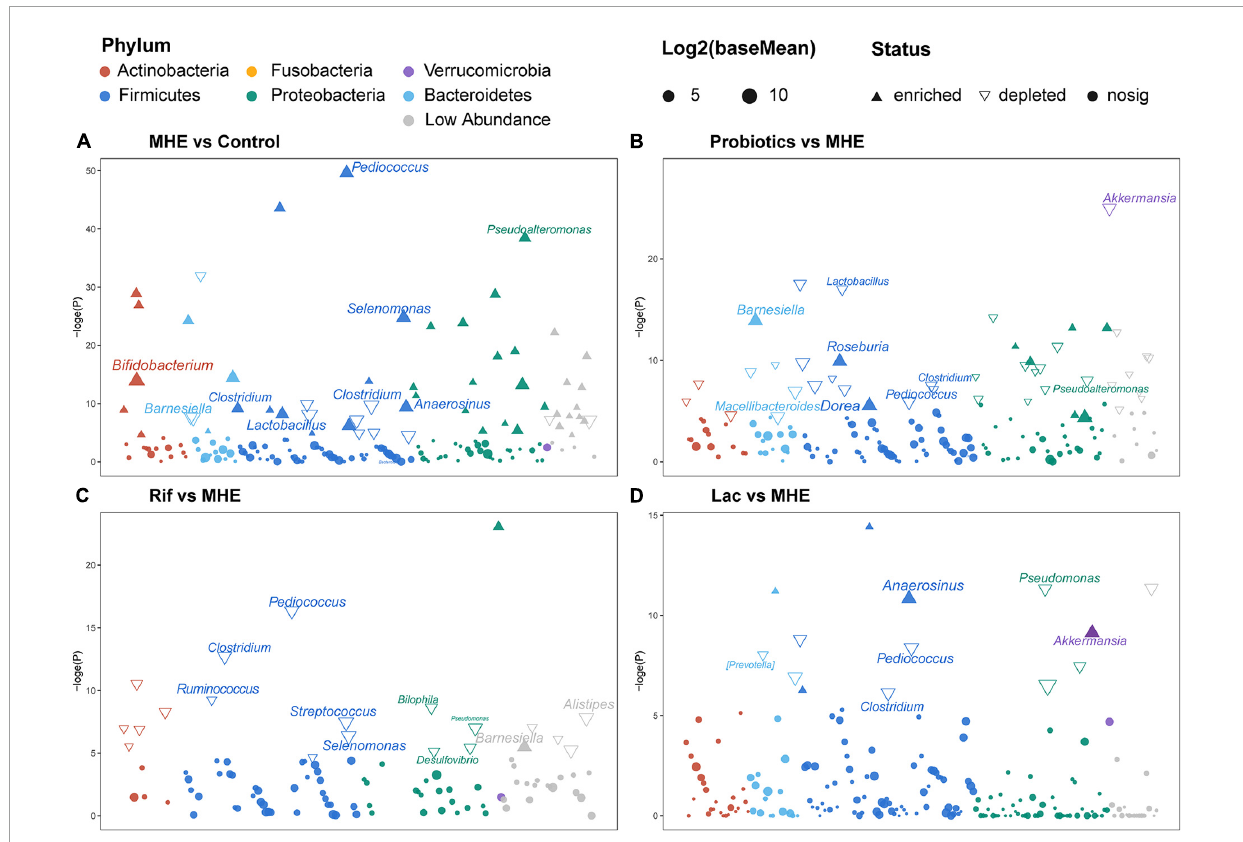
FIGURE4 Differential taxonomic features based on DESeq2 analysis. Changes in relative abundance of the gut microbiota between MHE patients and controls (A) , MHE patients before and after probiotics treatment (B) , MHE patients before and after rifaximin treatment (C) , and MHE patients before and after lactulose treatment (D) . Log2(baseMean): the log base 2 of base mean, the base mean is the mean of normalized counts of all samples, normalizing for sequencing depth. –loge(P): the negative of log base e of p